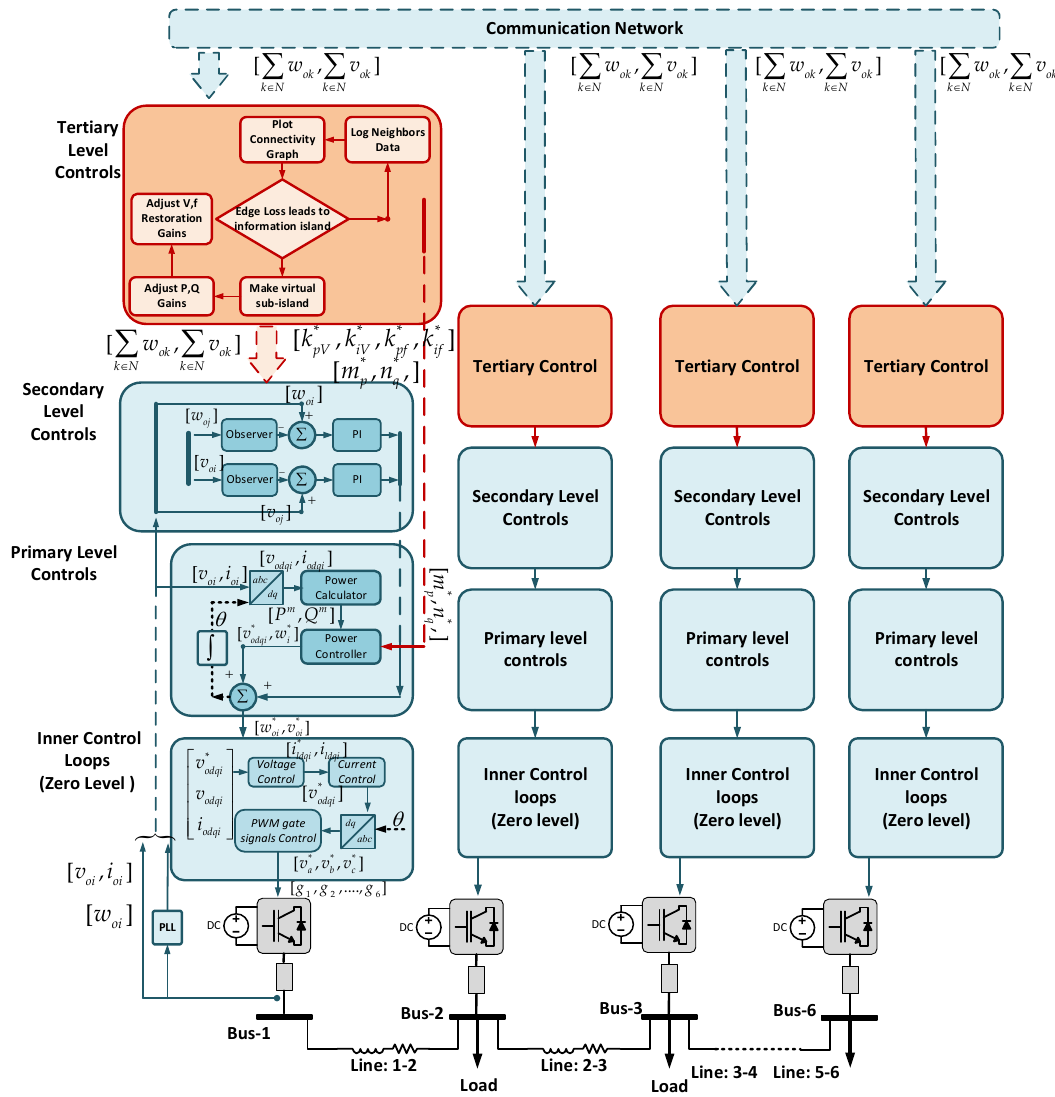
Figure 1. Distribution network and control system layout.